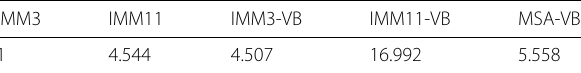
Table 3 Relative computational times for the Experiment 1